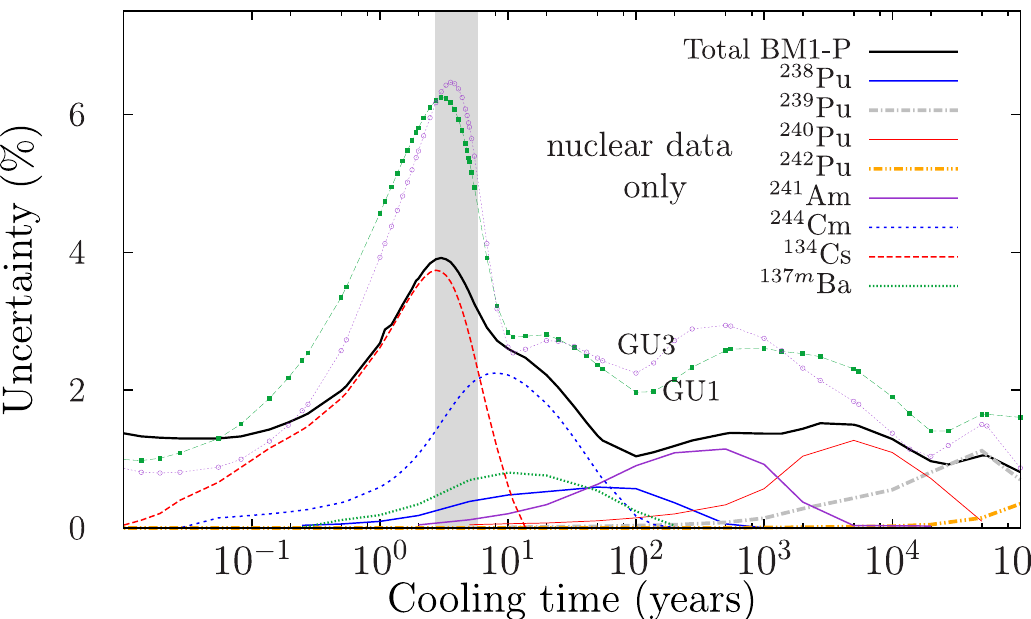
Fig. 7. Calculated decay heat uncertainties for the assembly containing the BM1 sample, due to nuclear data (with the ENDF/B- VIII.0 library). The ten most important contributors for the uncertainties are also presented. The dotted lines indicate the decay heat uncertainties from the GU1 and GU3